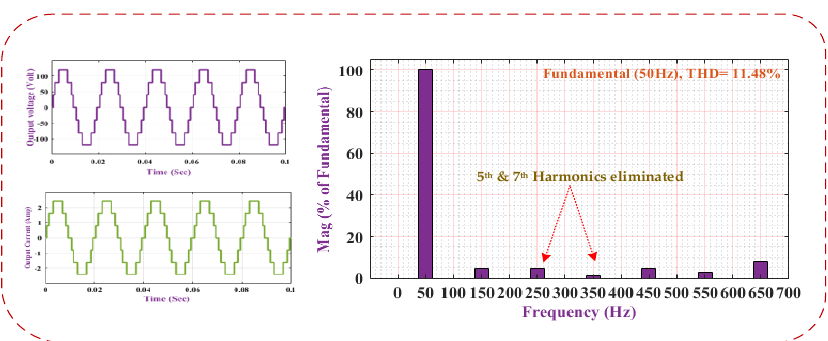
Figure 12. Seven-level outputs and the harmonic profile.